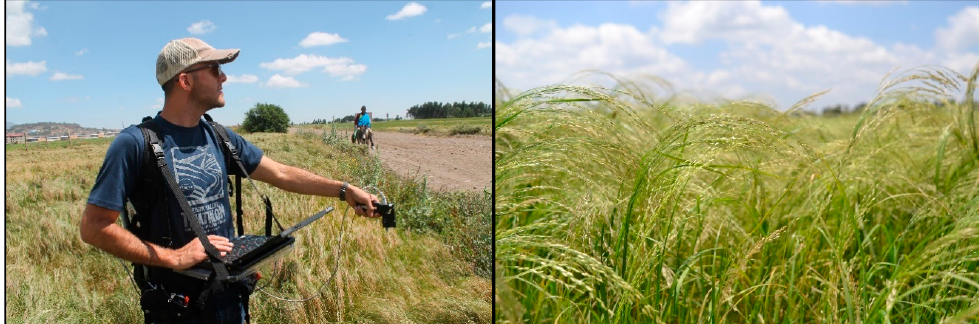
Figure 3. Use of spectroadiometer in the field ( left ) and a close-up of Eragrostis tef (tef; right